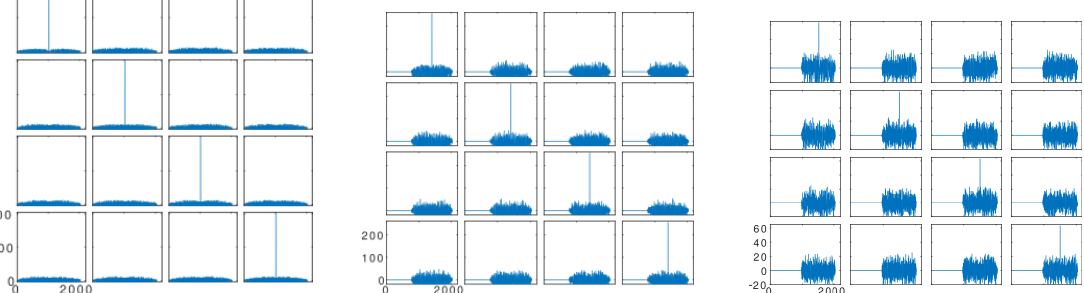
Figure 5. Autocorrelation of generated Kasami codes with 1023 bits ( left ), 255 bits ( middle ), and 63 bits ( right